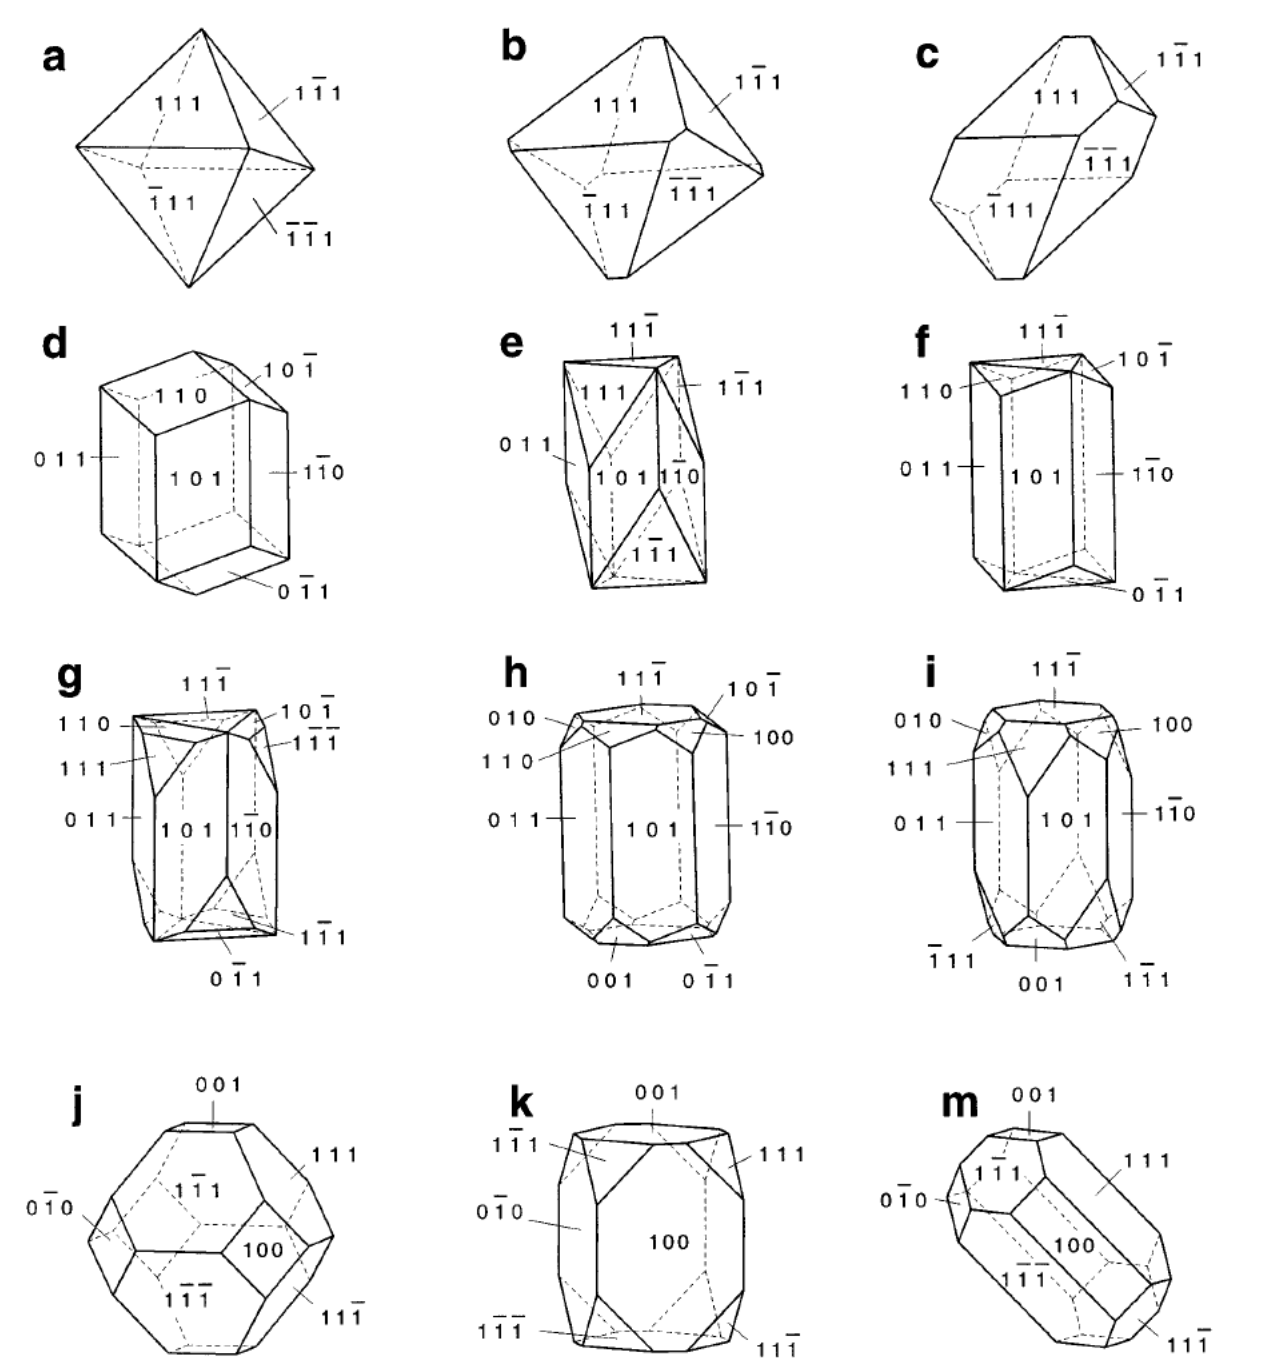
Figure 3. Shape combinations compatible with magnetite symmetry (Fd3m): ( a ) {111} (octahedron); ( b ) distorted {111}; ( c ) elongated {111}; ( d ) elongated {110}; ( e – g ) {110} + {111}; ( f ) {110} + {111}; ( h , i ) {110} + {111} + {100}; ( j ) {100} + {111} (cuboctahedron); ( k , m ) elongated {100} + {111}. The anisotropy of the environment could derive from an anisotropic flux of ions through the magnetosome membrane surrounding the crystal. The resulting crystals are distorted in a consistent species-specific manner. The cube {100}, octahedron {111}, and dodecahedron {110} can, with certain distortions, create a wide range of shapes, taking into consideration those observed in magnetosomes. Reprinted from [70], American Mineralogist, Vol. 83, Devouard B., Pósfai M., Hua X., Bazylinski D.A., Frankel R.B., Buseck P.R., “Magnetite from magnetotactic bacteria: Size distributions and twinning”, pp. 1387–1398. 1998. Copyright © 1998, with permission from the authors and The Mineralogical Society of America.